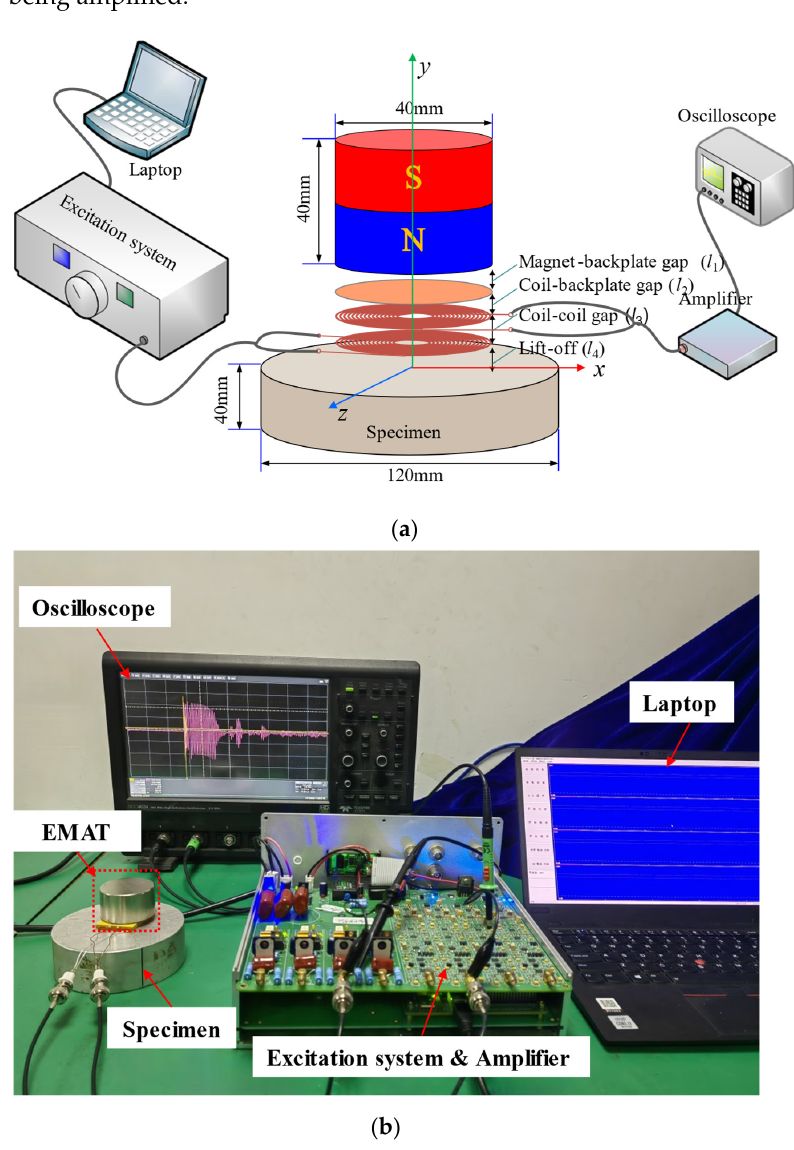
Figure 7. Experimental platform used to obtain the EMAT signals. ( a ) Diagram of the experimental settings. ( b ) Photograph of the experimental